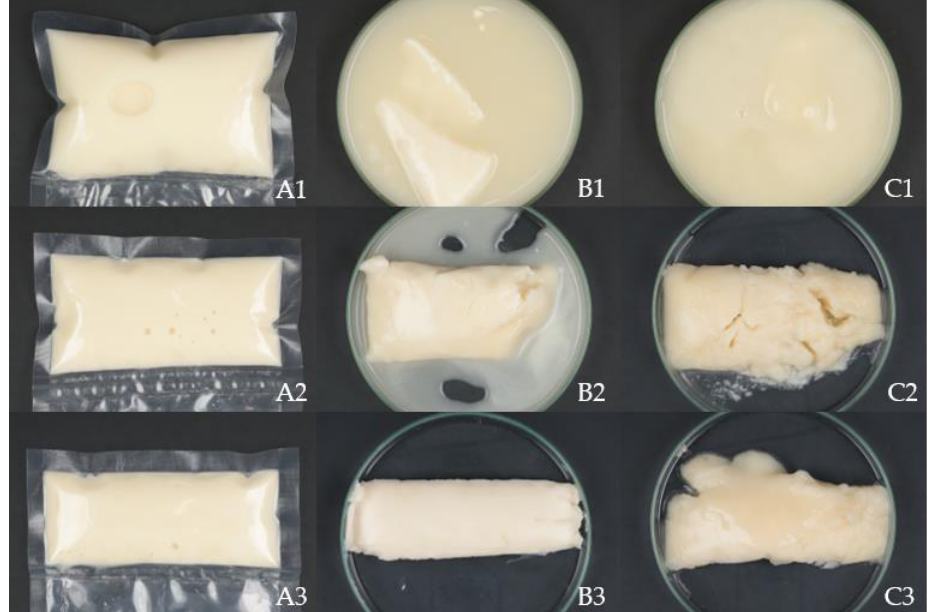
Figure 1. Visual changes of untreated and selected treated cassava flour slurries; where ( A1 ) is 0.10 MPa, 10% flour concentration; ( A2 ) is 0.10 MPa, 20% flour concentration; ( A3 ) is 0.10 MPa, 30% flour concentration; ( B1 ) is 600 MPa – 10 min, 10% flour concentration; ( B2 ) is 600 MPa – 10 min, 20% flour concentration; ( B3 ) is 600 MPa – 10 min, 30% flour concentration; ( C1 ) is 600 MPa – 30 min, 10% flour concentration ; ( C2 ) is 600 MPa – 30 min, 20% flour concentration; ( C3 ) is 600 MPa – 30 min, 30% flour concentration.